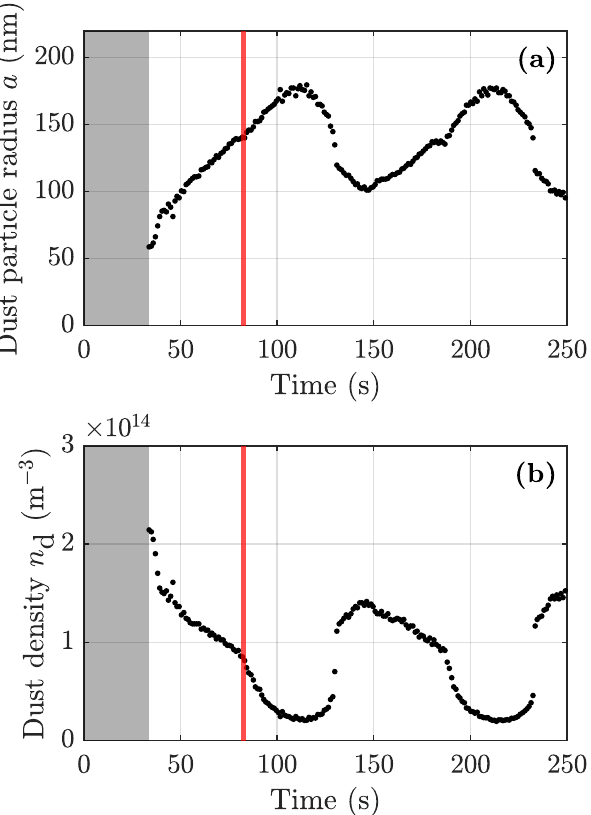
Figure 5. General result from the optimization procedure. The dust particle radius a is shown in panel ( a ) and the dust density n d in panel ( b ). The gray-shaded area indicates the time period after discharge ignition during which the transmittance remains similar to a pristine plasma, which inhibits the proper determination of the dust particle size and density. The red lines mark the appearance of the void region, after which the path length L is no longer constant. A constant value of the electron temperature T e = 3eV and the negative ion density n i − = 4 n e,initial are